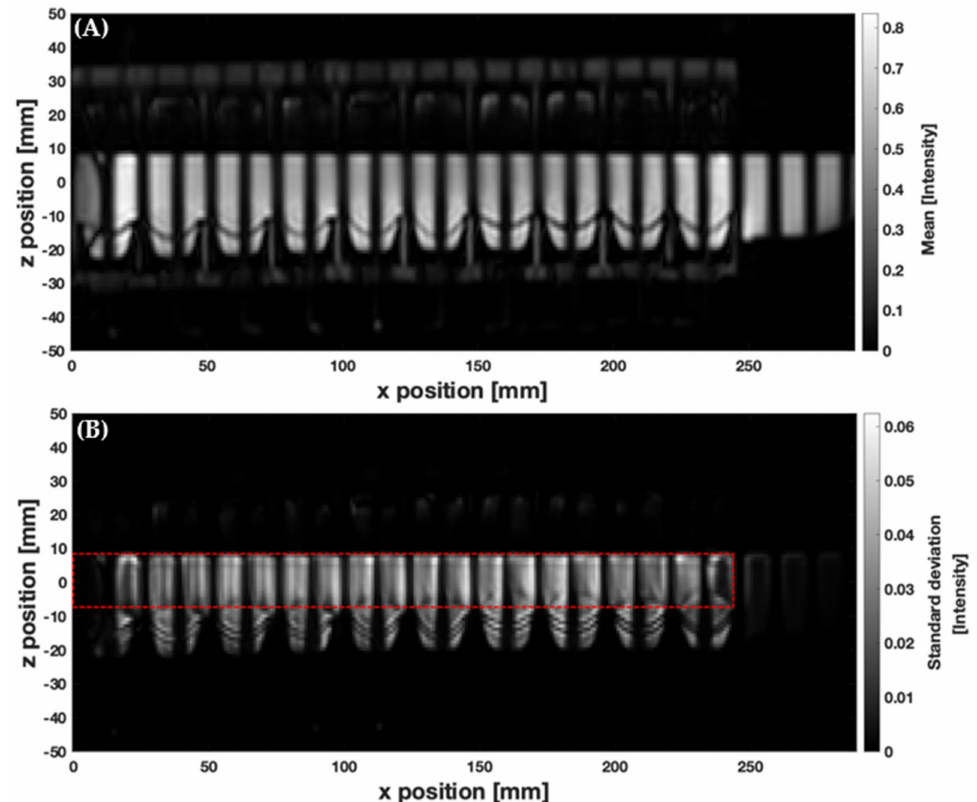
Figure 3. Processed images from tagged cine-MRI data showing ( A ) a mean voxel intensity map and ( B ) the corresponding voxel standard deviation map (calculated over 100 dynamic images). The red dashed line depicts the ROI, R, that encloses the DCM